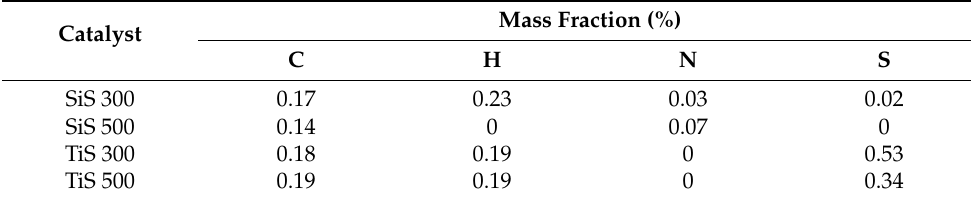
Table 2. Elemental analysis of sulfated catalysts.